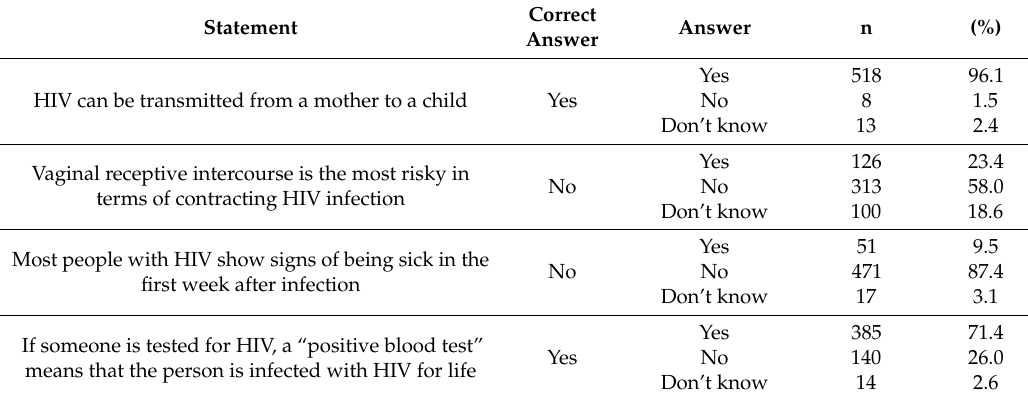
Table 2. Knowledge on HIV/AIDS; final year medical students, Poland, 2013–2016; n =